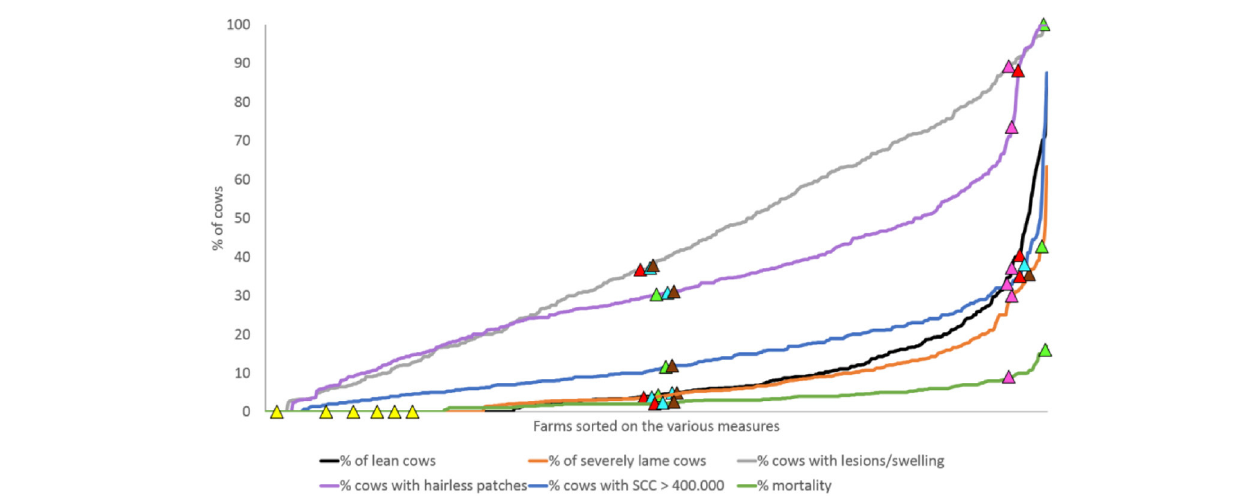
FIGURE 1 | One of the graphs presented to experts in the second survey showing the distribution of all herds in the database ( n = 491) for the six selected measures. Colored triangles mark six (of the 12) focus